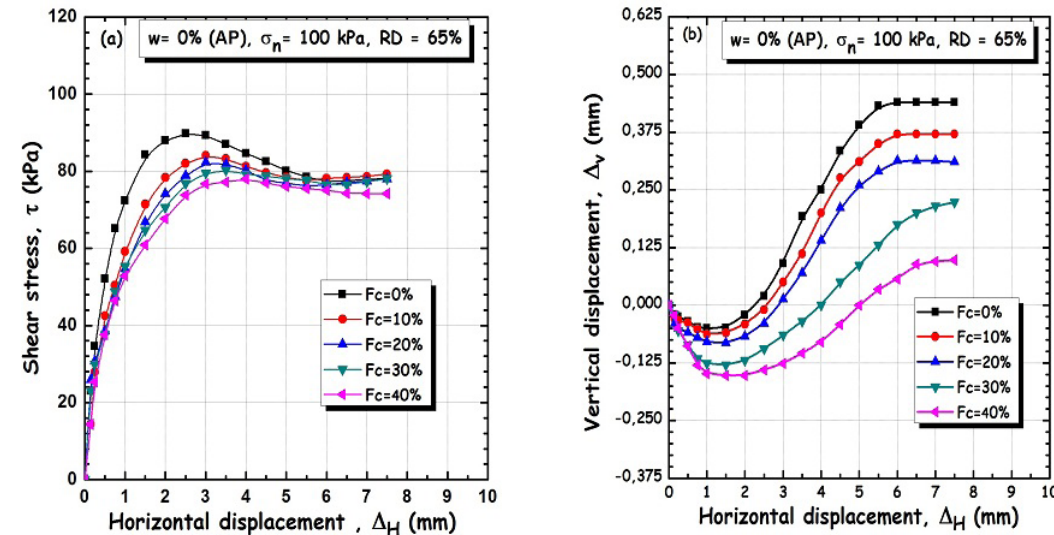
= 100 kPa): (a) variation of the shear n